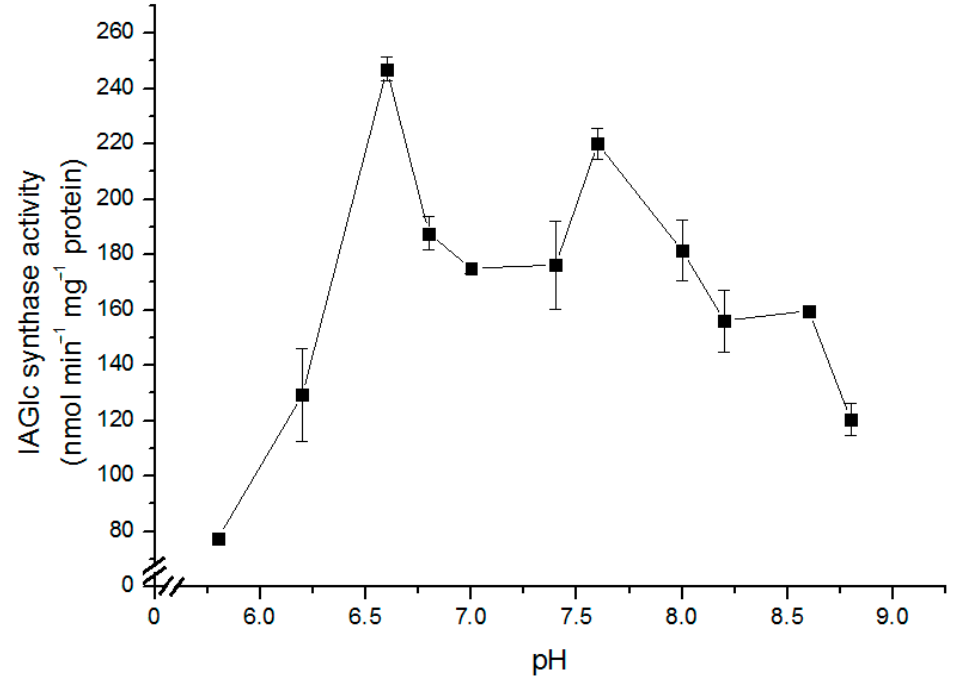
Figure 2. Effect of pH on the IAGlc synthase activity. Enzyme activity was determined using [ 14 C]IAA after TLC (thin layer chromatography). For this assay, 25 mM HEPES buffers (pH 5.8; 6.2; 6.6; 6.8; 7.0; 7.4; 7.6; 8.0; 8.2; 8.6 and 8.8) were used. Catalytic activity was expressed as the means ± SD for three